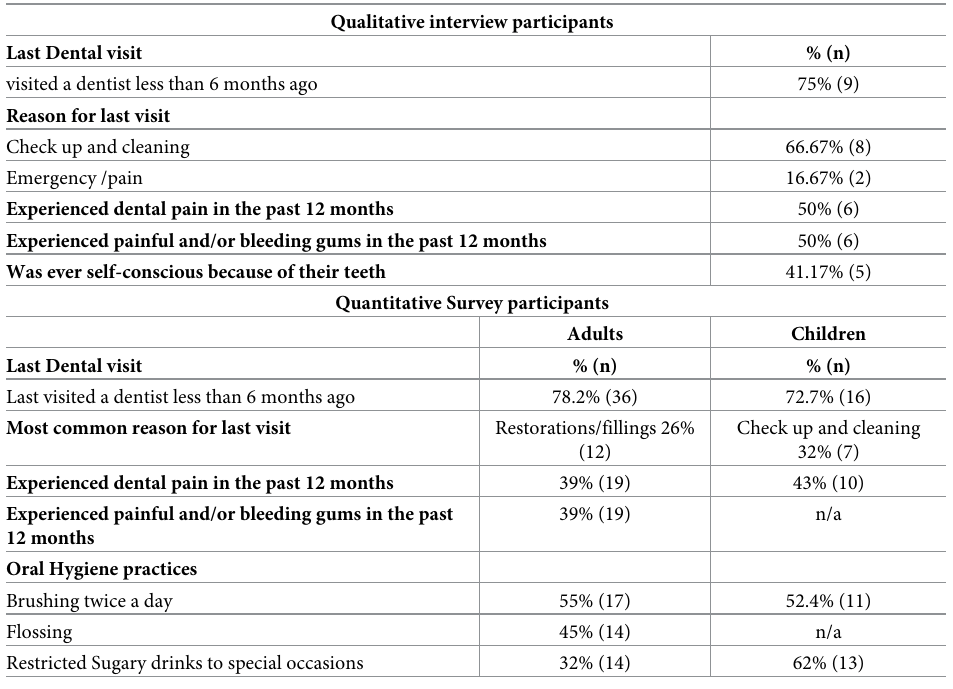
Table 2. Participants’ oral health characteristics.